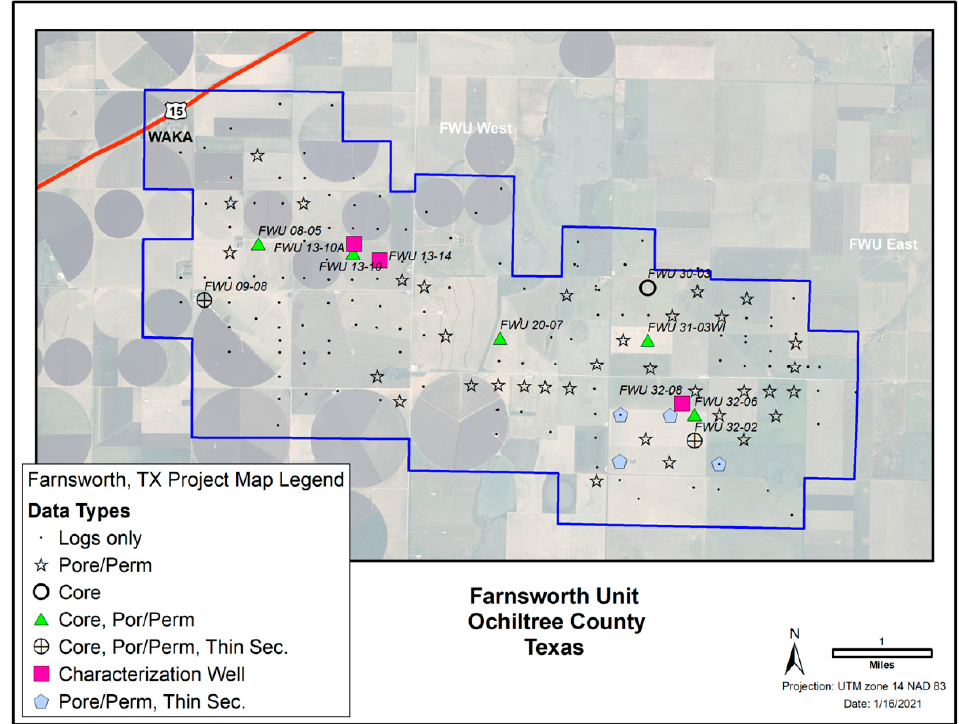
Figure 1. Map of Farnsworth Field Unit (FWU), Ochiltree County, Texas, showing locations of wells and various data types collected from wells. FWU 13-10A, 13-14, and 32-8 were drilled for this project.